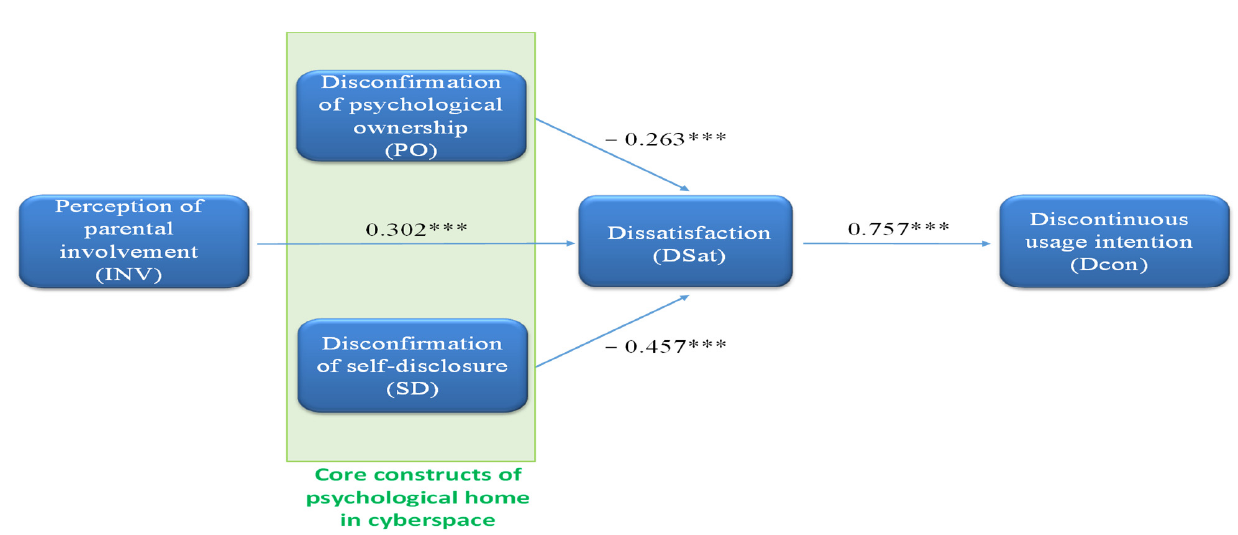
Table 5. Explanatory power ( R 2 ) and effect size of the model.